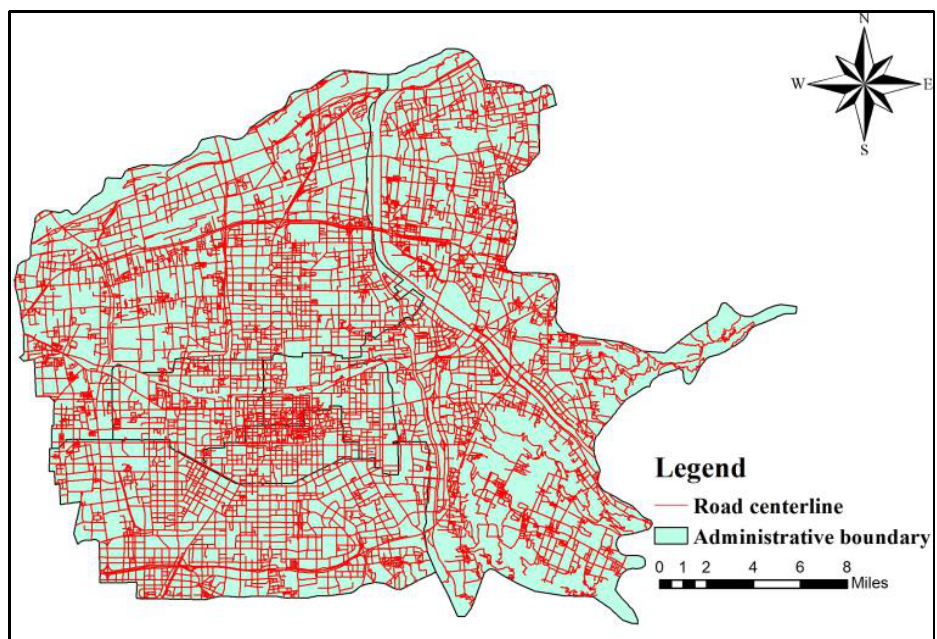
Figure 3. The road network line segment map of the main urban area of Xi’an .